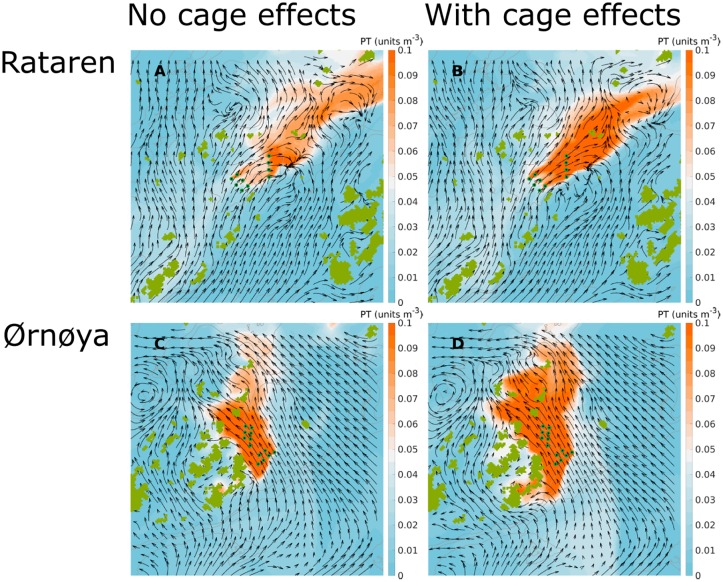
Simulated dispersal of passive tracers.Snap shots (instantaneous images, medio August 2015) of passive tracers released from the Rataren (A, B) and Ørnøya (C, D) farms with (B, D) and without (A, C) including the effects of the cages. The results are depth integrated (0 –10 m) passive tracer concentrations. The gray curves in the background are 30, 50 and 100 m isobaths. The curved arrows indicate the water current field. The release points of the passive tracer are indicated by green-black dots. The distance between them are approx. 100 m.